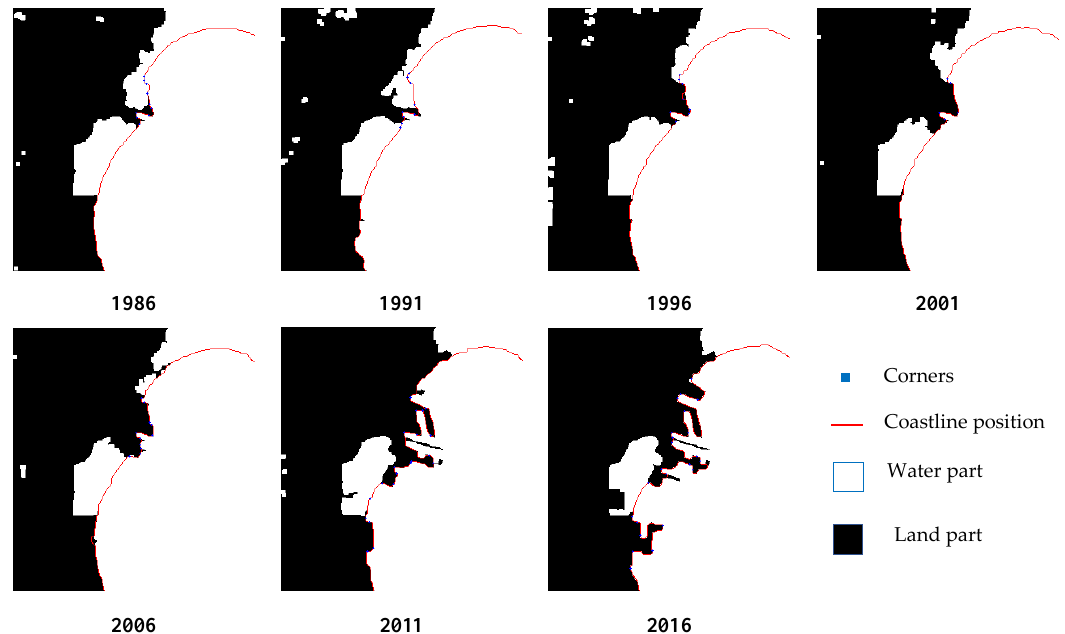
Figure 2. Extracted scale-invariant features of the coastlines in the selected